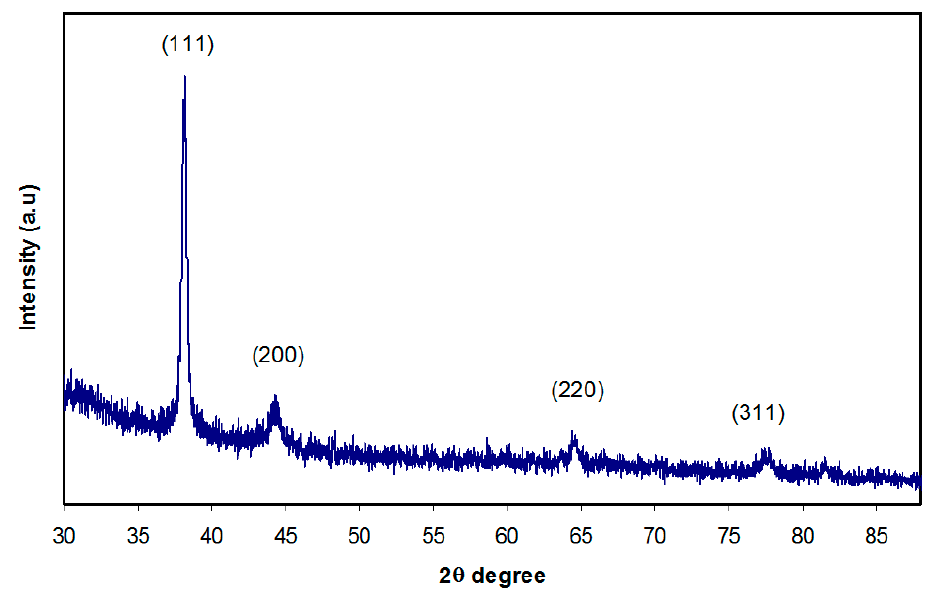
Figure 4. Pattern of interconnected spherical Ag Figure 4. pattern of interconnected spherical Ag nanoparticles.